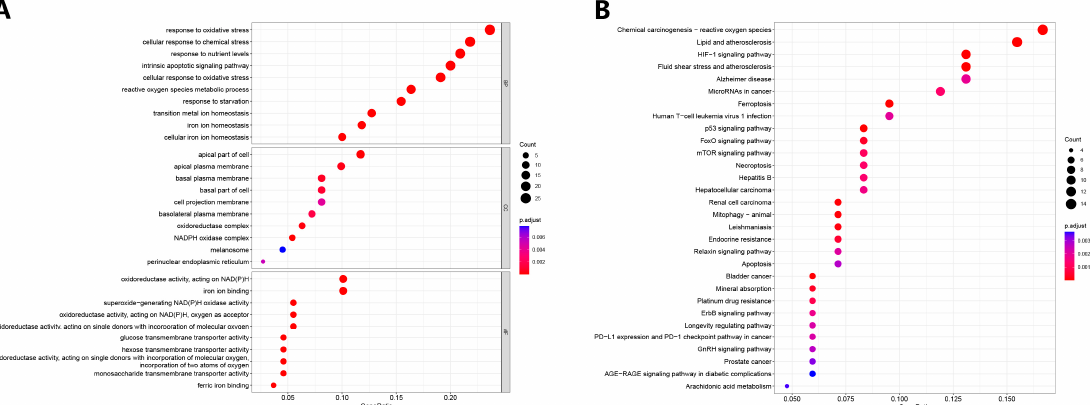
Figure 2. Gene ontology (GO) and Kyoto Encyclopedia of Genes and Genomes (KEGG) enrichment analyses of differentially expressed ferroptosis-related genes. ( A ) GO results. ( B ) KEGG